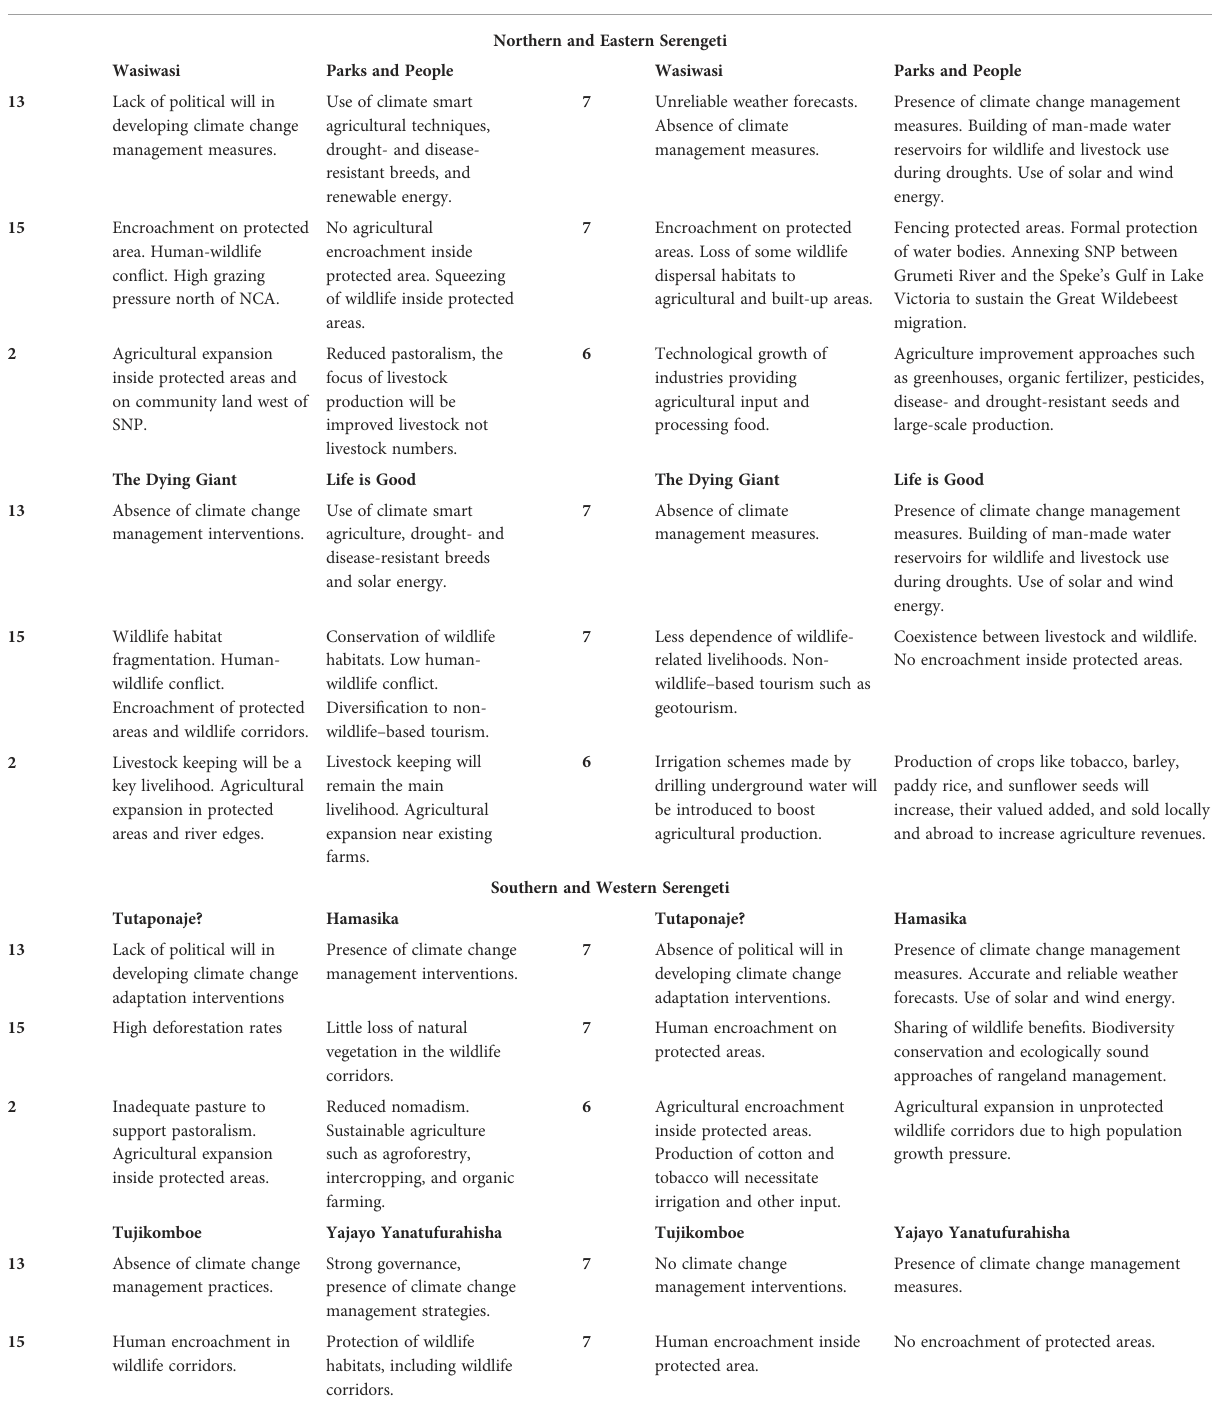
TABLE 1 Connection between co-produced scenarios of future LULCC, and SDGs 13 (climate action), 15 (life on land), and 2 (zero hunger) for 2030 and AU Agenda 2063 goals 7 (environmentally sustainable and climate-resilient economies and communities) and 6 (modern agriculture for increased